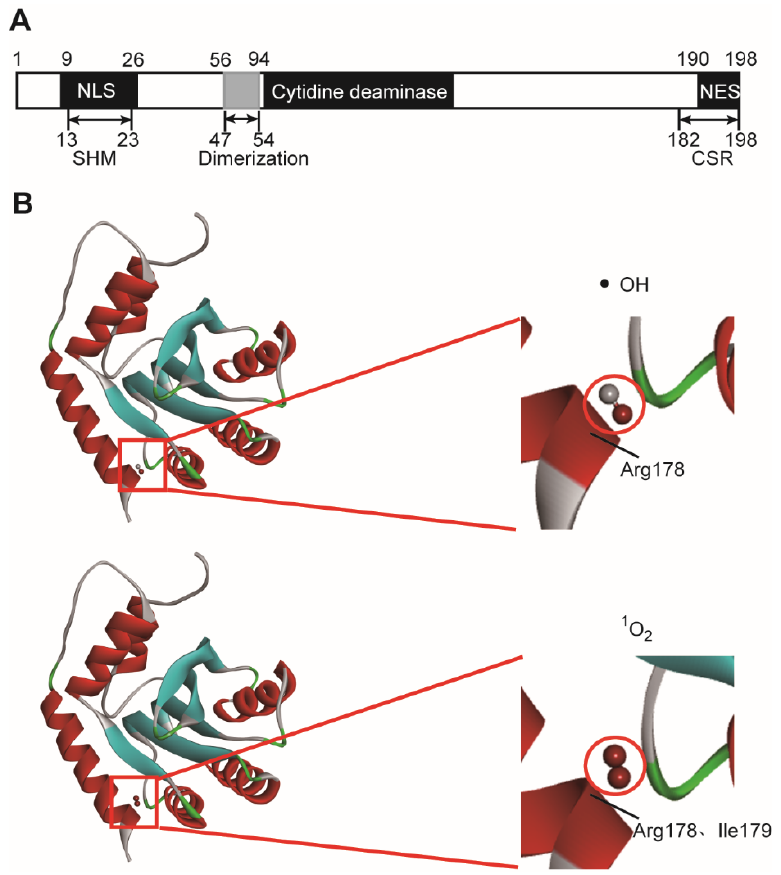
Figure 3. The a ffi nity between AID and ROS (including · OH and 1 O 2 ). ( A ) The primary structure of AID protein with including the functional domains. SHM, somatic hypermutation; CSR, class switch recombination. NLS, nuclear localization sequence; NES, nuclear export sequence. ( B ) Affinity sim- switch recombination. NLS, nuclear localization sequence; NES, nuclear export sequence. ( B ) Affinity ulation between singlet oxygen ( 1 O 2 ) or hydroxyl radicals ( · OH) and AID was performed by the simulation between singlet oxygen ( 1 O 2 ) or hydroxyl radicals ( · OH) and AID was performed by CDOCKER program. AID and ROS structures were constructed and optimized using Materials Stu- dio. The red square fields were enlarged and are displayed on the right, the circled drugs indicated the CDOCKER program. AID and ROS structures were constructed and optimized using Materials OH or 1 O 2 , red indicates O, and gray indicates H. Arg178 denotes that the 178 amino acid on AID is Studio. The red square fields were enlarged and are displayed on the right, the circled drugs indicated Arginine; Ile179 denotes that the 178 amino acid on AID is Isoleucine. OH or 1 O 2 , red indicates O, and gray indicates H. Arg178 denotes that the 178 amino acid on AID is Arginine; Ile179 denotes that the 178 amino acid on AID is